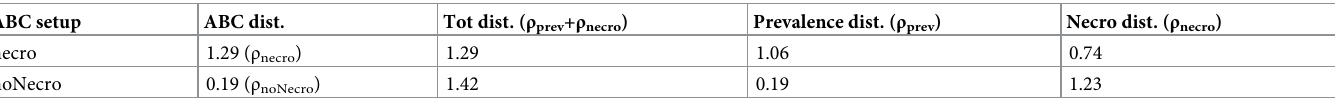
Minimum ABC distances for necro and noNecro calibration setups. The column ‘ABC dist.’ shows the actual ABC distance used for calibration. The column ‘Tot dist’ shows the sum of ρ prov and ρ necro as defined in Eq ( 11 ). The ρ necro distance for noNecro calibration setup is showed here only to be compared with the necro calibration setup but is not included in the ABC distance of noNecro calibration